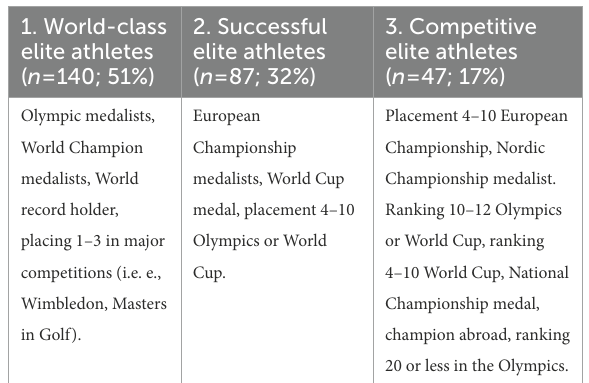
TABLE 1 Participants athlete classification based on their highest sporting